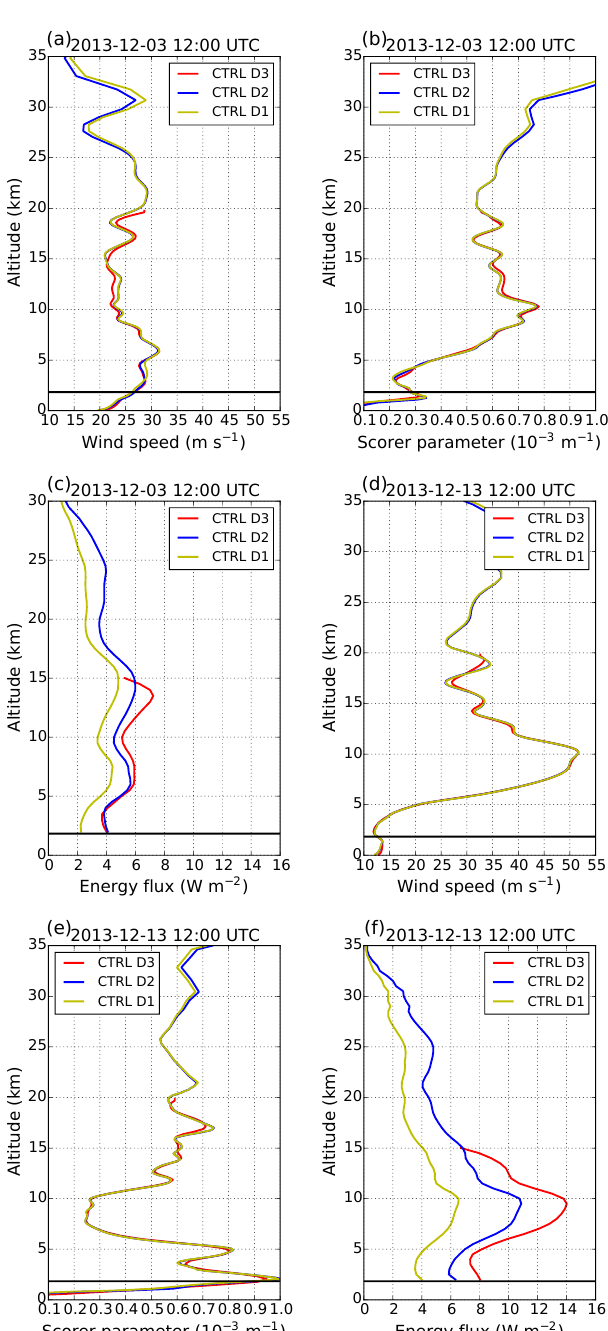
Figure 8. Area-averaged vertical profiles during (a–c) IOP1 and (d–f) IOP5. Cross-mountain horizontal wind speed (from a direc- tion of 300 ◦ ) and Scorer parameter are averaged over the upstream area from 69 to 70 ◦ N and 10 to 15 ◦ E, while vertical energy fluxes are averaged over the mountain area within 67 to 69 ◦ N and 15 to 25 ◦ E (see black boxes in Fig. 4a and b). The thick horizontal black line marks the maximum mountain peak height within the mountain